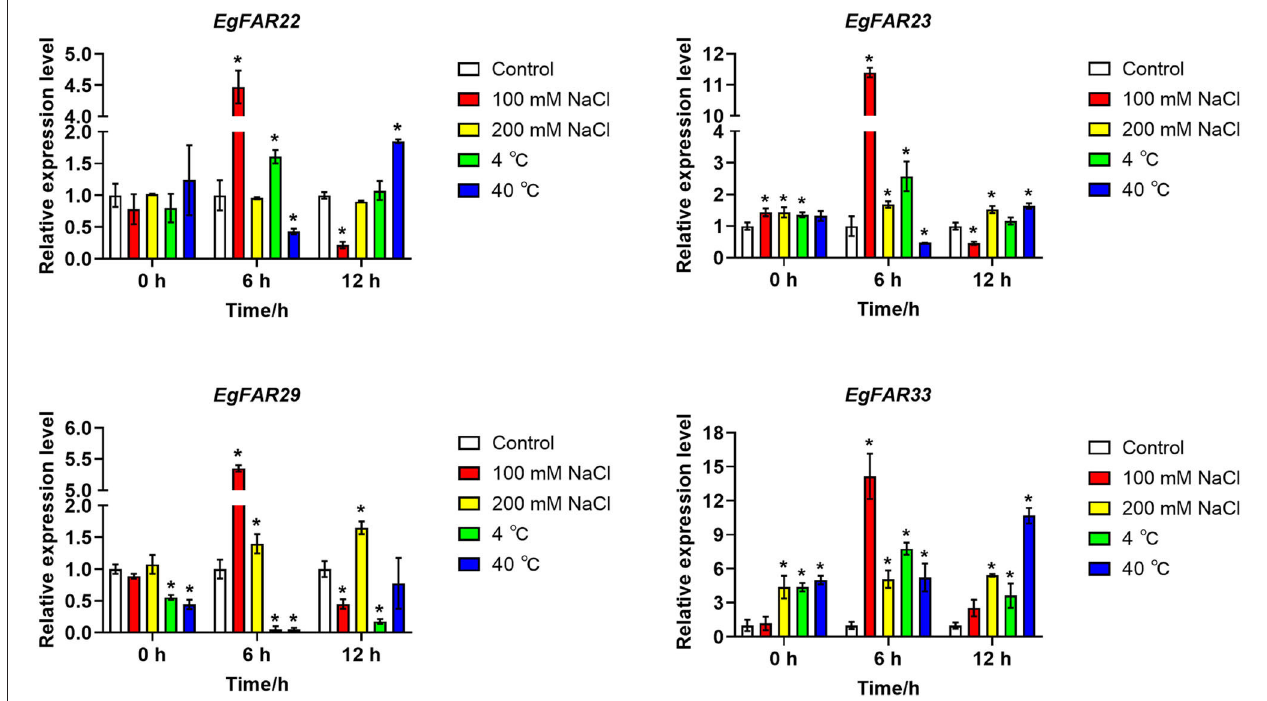
FIGURE 8 | Expressions of four FAR1/FHY3 genes in response to salt and temperature stresses. The qRT-PCRs were conducted after 0, 6, and 12 h of stress treatments. The low salinity was treated with 100 mM NaCl, and the high salinity was 200 mM NaCl, whereas the control was treated with distilled water. The low temperature was treated with 4 ◦ C and the high temperature was 40 ◦ C, whereas the control temperature was 25 ◦ C. Average data with standard errors is presented (* p <